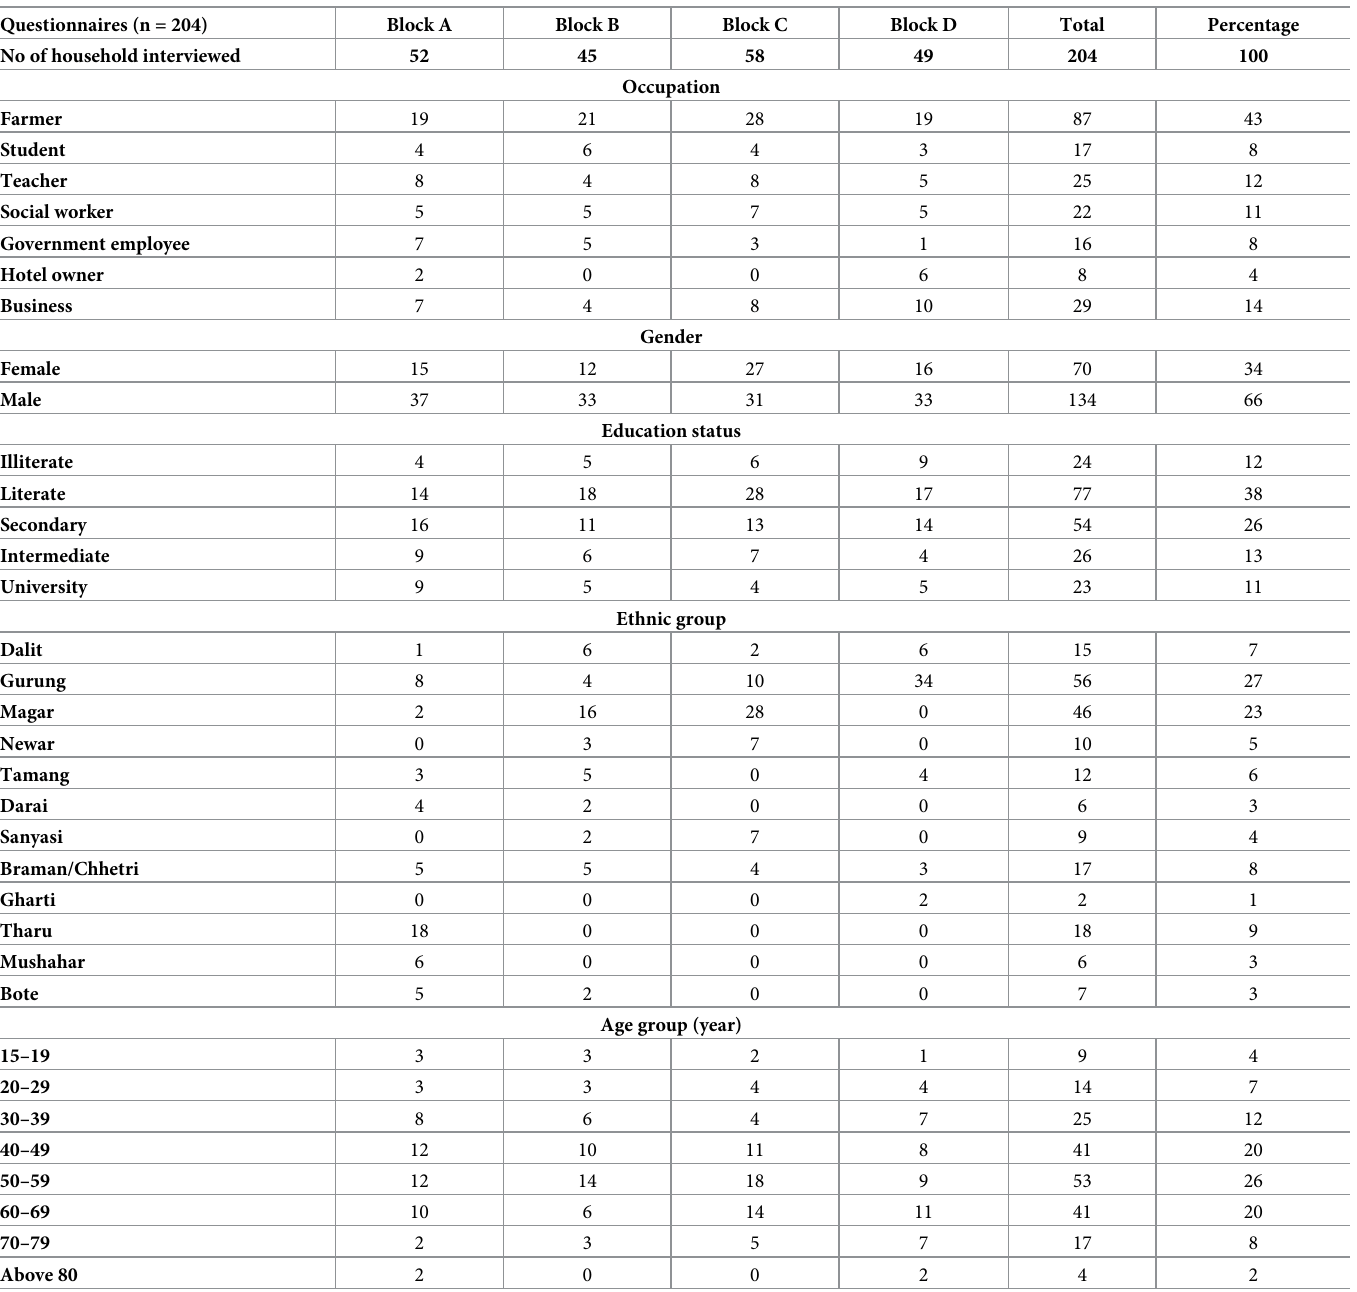
Table 2. Demographic profile of the